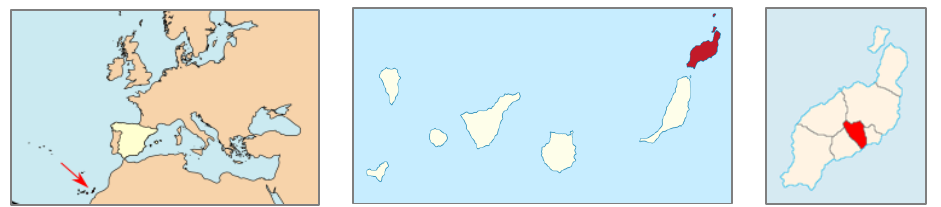
Figure 1. ( Left ): Location of the Canary Islands, a region of Spain. ( Center ): Canary Islands and Lanzarote in red. ( Right ): Lanzarote and SB town in red.